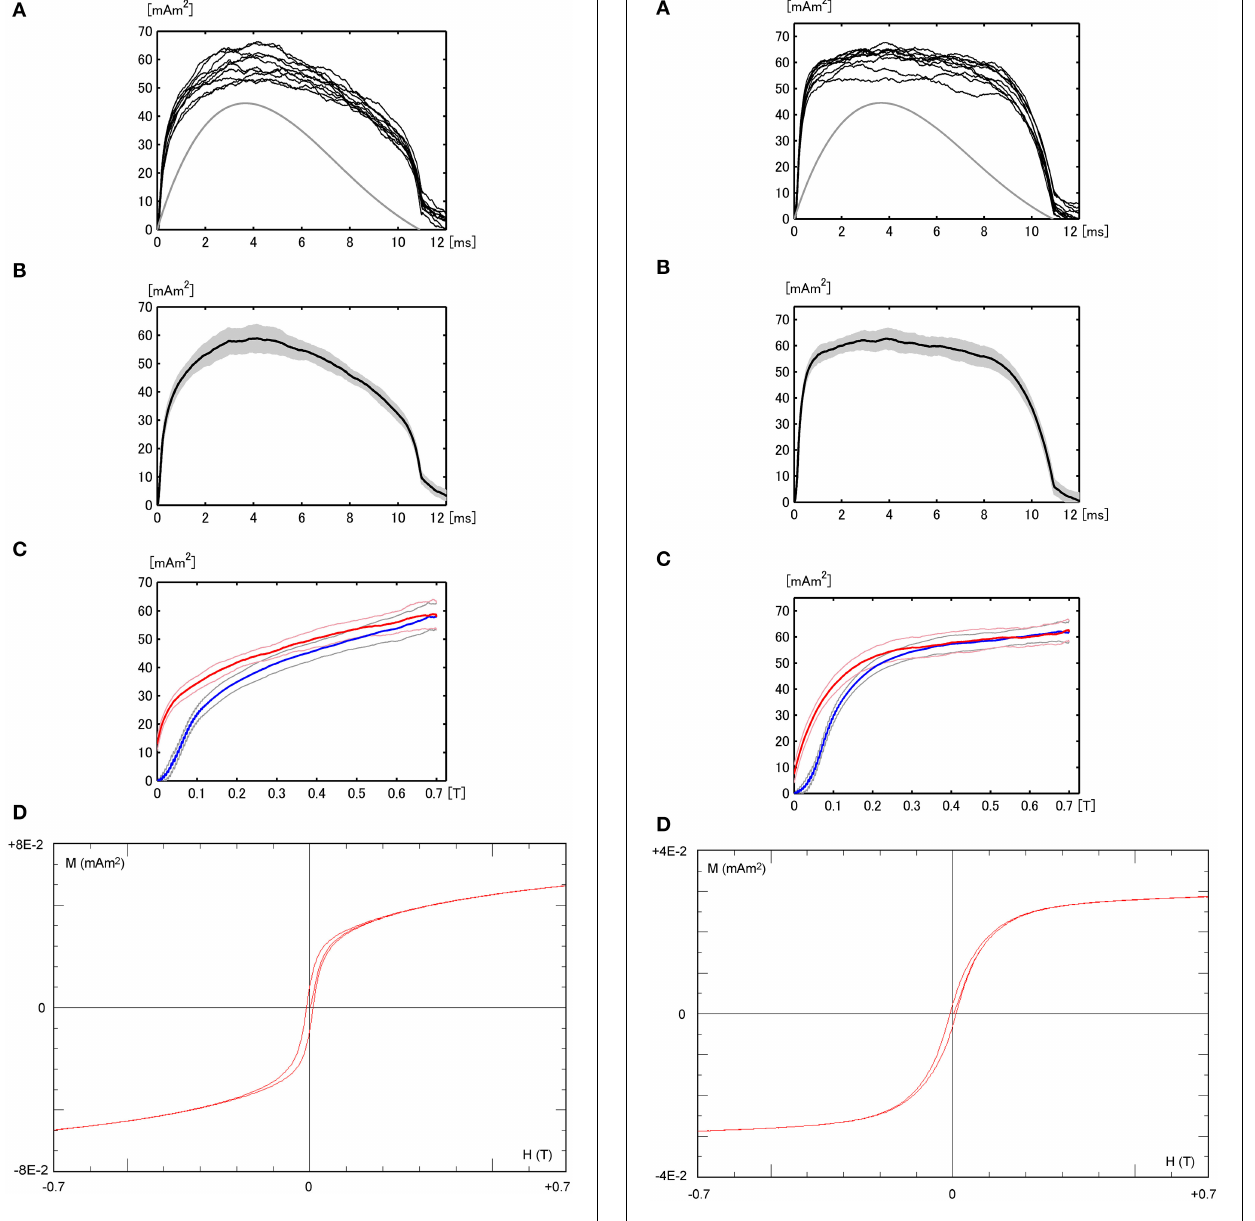
FIGURE 7 | (A) M–t curves from measurements repeated 10 times for sample OT73-4-3, with the H-t curve (gray, not to scale). (B) Mean M–t curve and the error range (gray). (C) Mean M–H curve and associated error range for the increasing field (blue) and reducing field (red). (D) Hysteresis loop of OT73-4-3 (18.5mg) including magnetization after initial